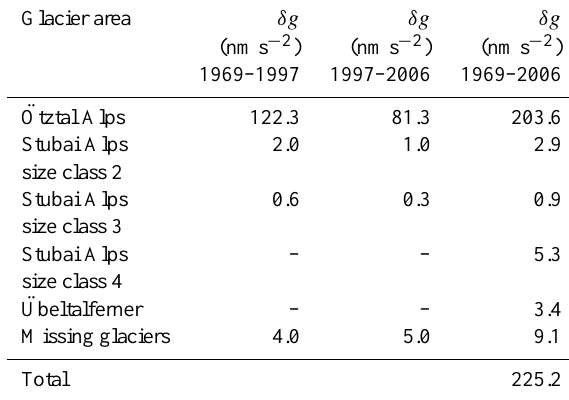
Table 1. Computed gravity effects ( δg ) due to ablation for all con- sidered glacier areas for the periods 1969–1997, 1997–2006 and 1969–2006.